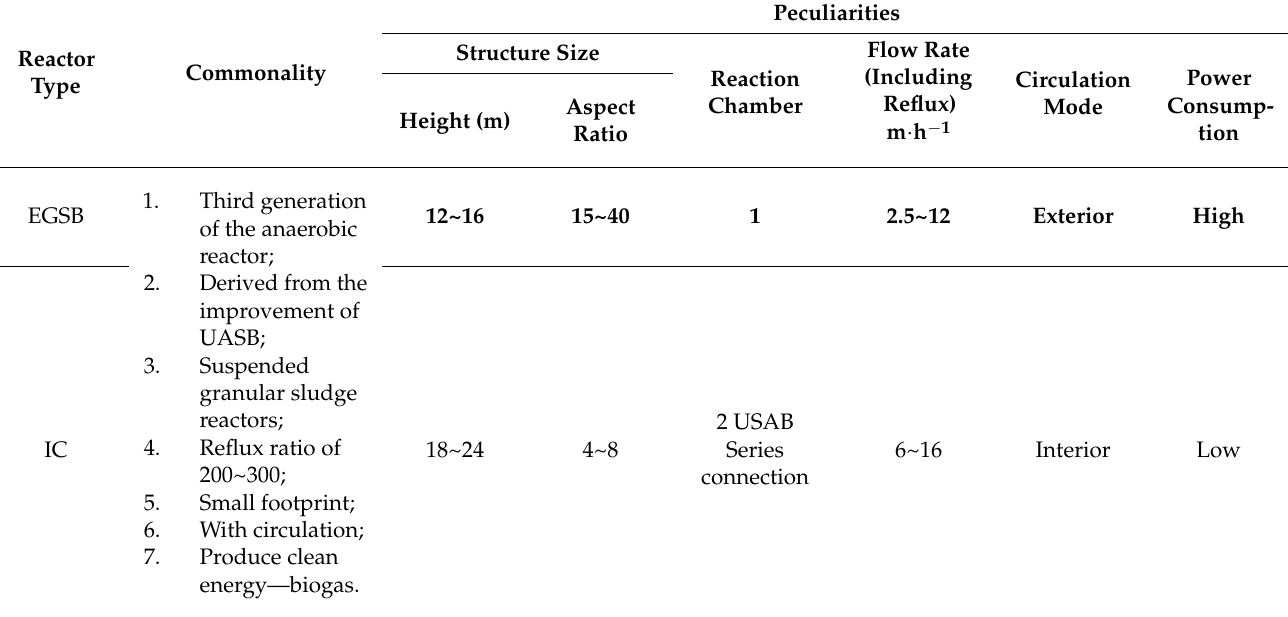
Table 1. Main characteristics of EGSB and IC